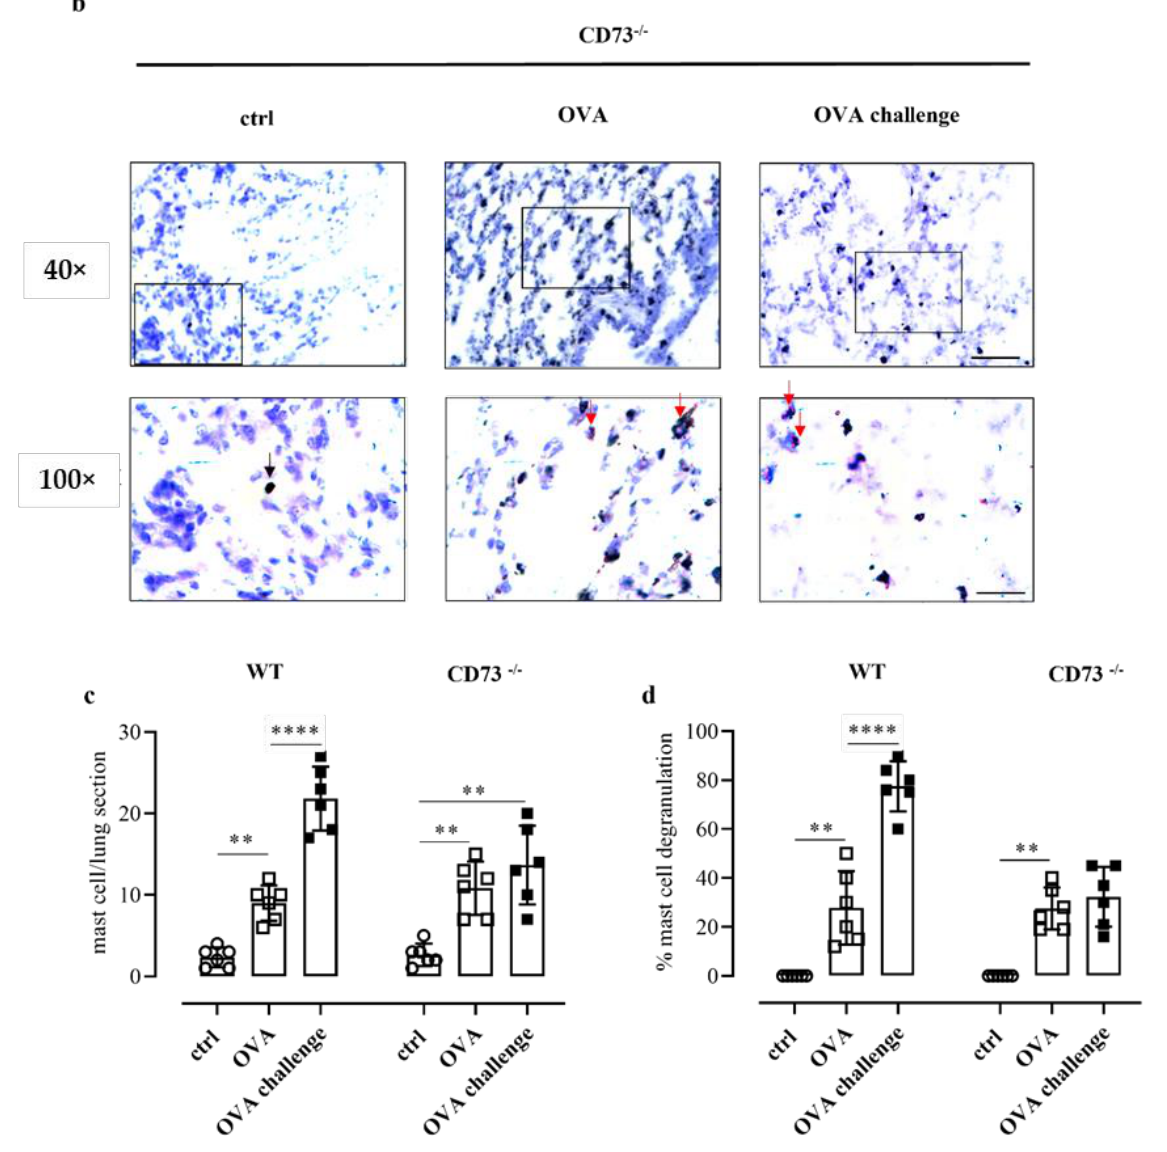
Figure 3. Representative photomicrographs of toluidine blue-stained lung sections from control and OVA-sensitized and challenged WT ( a ) and CD73 − / − mice ( b ). The number of pulmonary mast cells as well as a differentiation between non-degranulated (deep blue, black arrows) and degranulated (light blue, red arrows) and the percentage of mast cell degranulation was performed ( c , d ). Scale bar: 50 µ m and 20 µ m. Data are expressed as means ± SE of six mice per group. ** p < 0.01 and **** p < 0.0001 (one-way ANOVA followed by Bonferroni’s Multiple Comparison